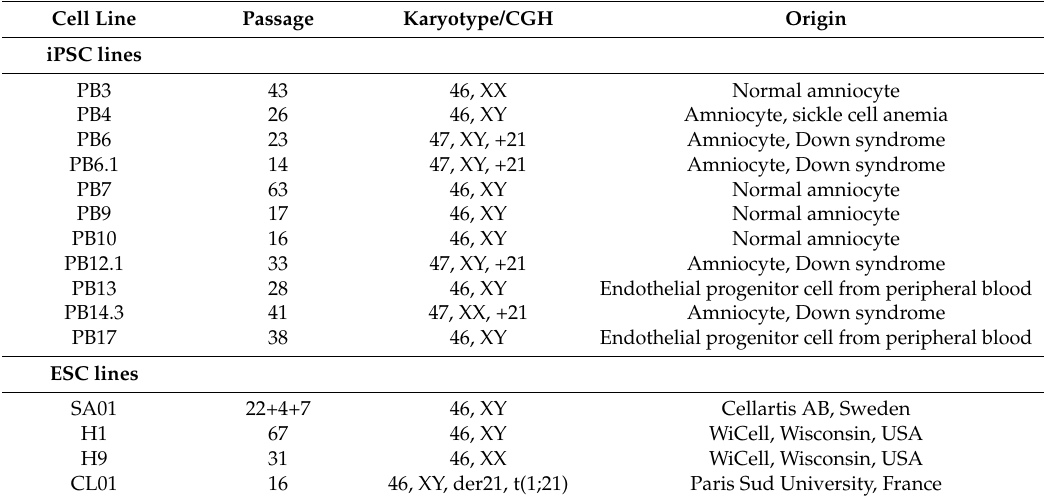
Table 1. Human pluripotent stem cell (hPSC) lines used in this